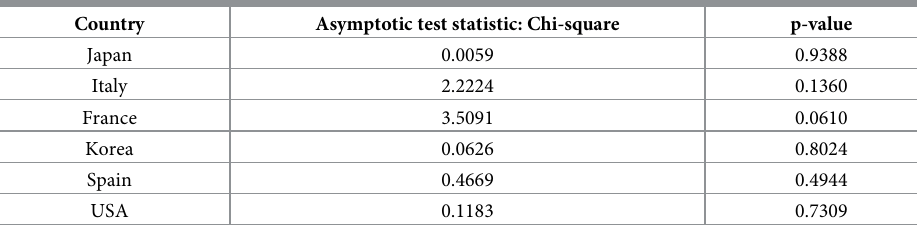
Country Asymptotic test statistic: Chi-square p-value Japan